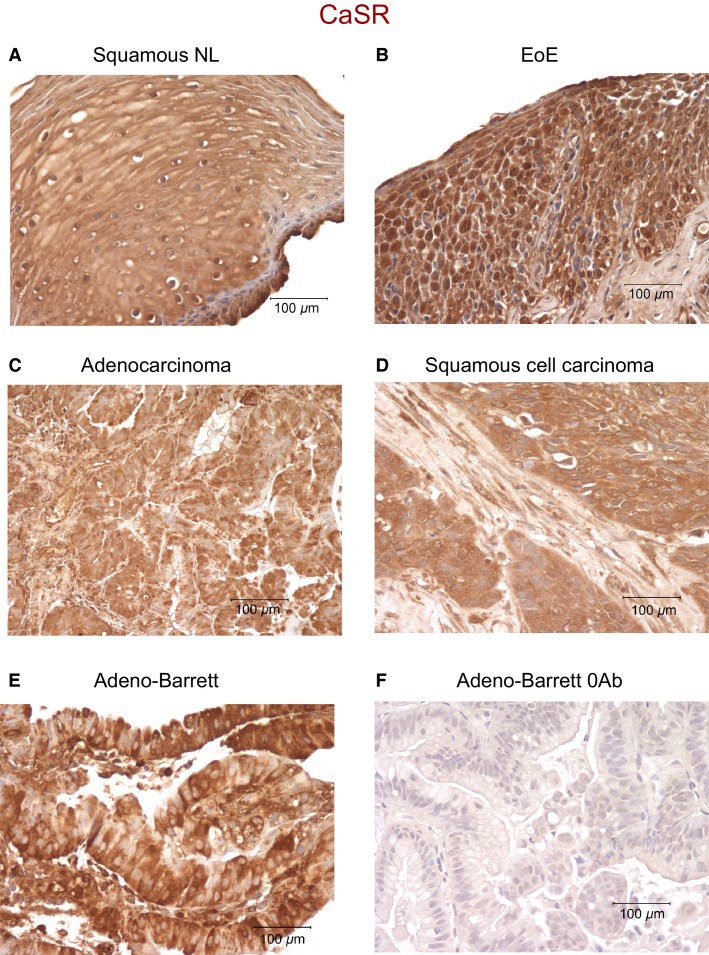
CaSR expression in human esophageal tissues. Positive staining for CaSR is indicated by brown deposits. (A) shows a section from a normal (NL) esophageal biopsy, (B) biopsy from eosinophilic esophagitis patient (EoE), (C) adenocarcinoma, (D) squamous cell carcinoma, (E) Barrett’s adenocarcinoma. All sections were positive for CaSR indicating the presence of the receptor in the esophageal tissues. (F) shows an esophageal section where the primary antibody was omitted from the staining procedure. The experiment was repeated three times using samples from two adenocarcinoma patients, two adenocarcinoma with Barrett’s patients, three squamous cell carcinoma patients, three eosinophilic esophagitis, and three normal patients.